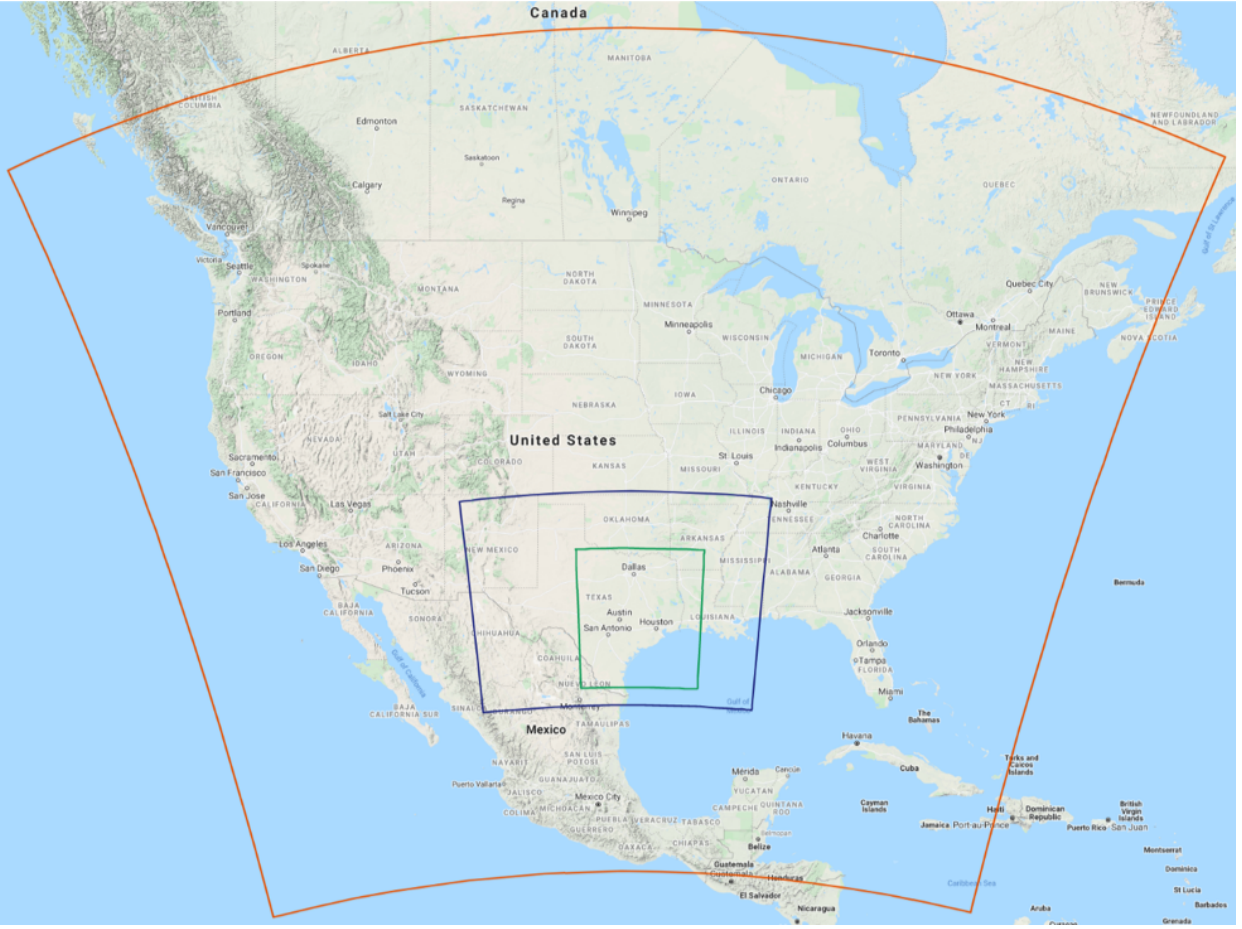
Figure 1. CAMx 36, 12, and 4km modeling domains. The underlaid image is from © Google Maps.